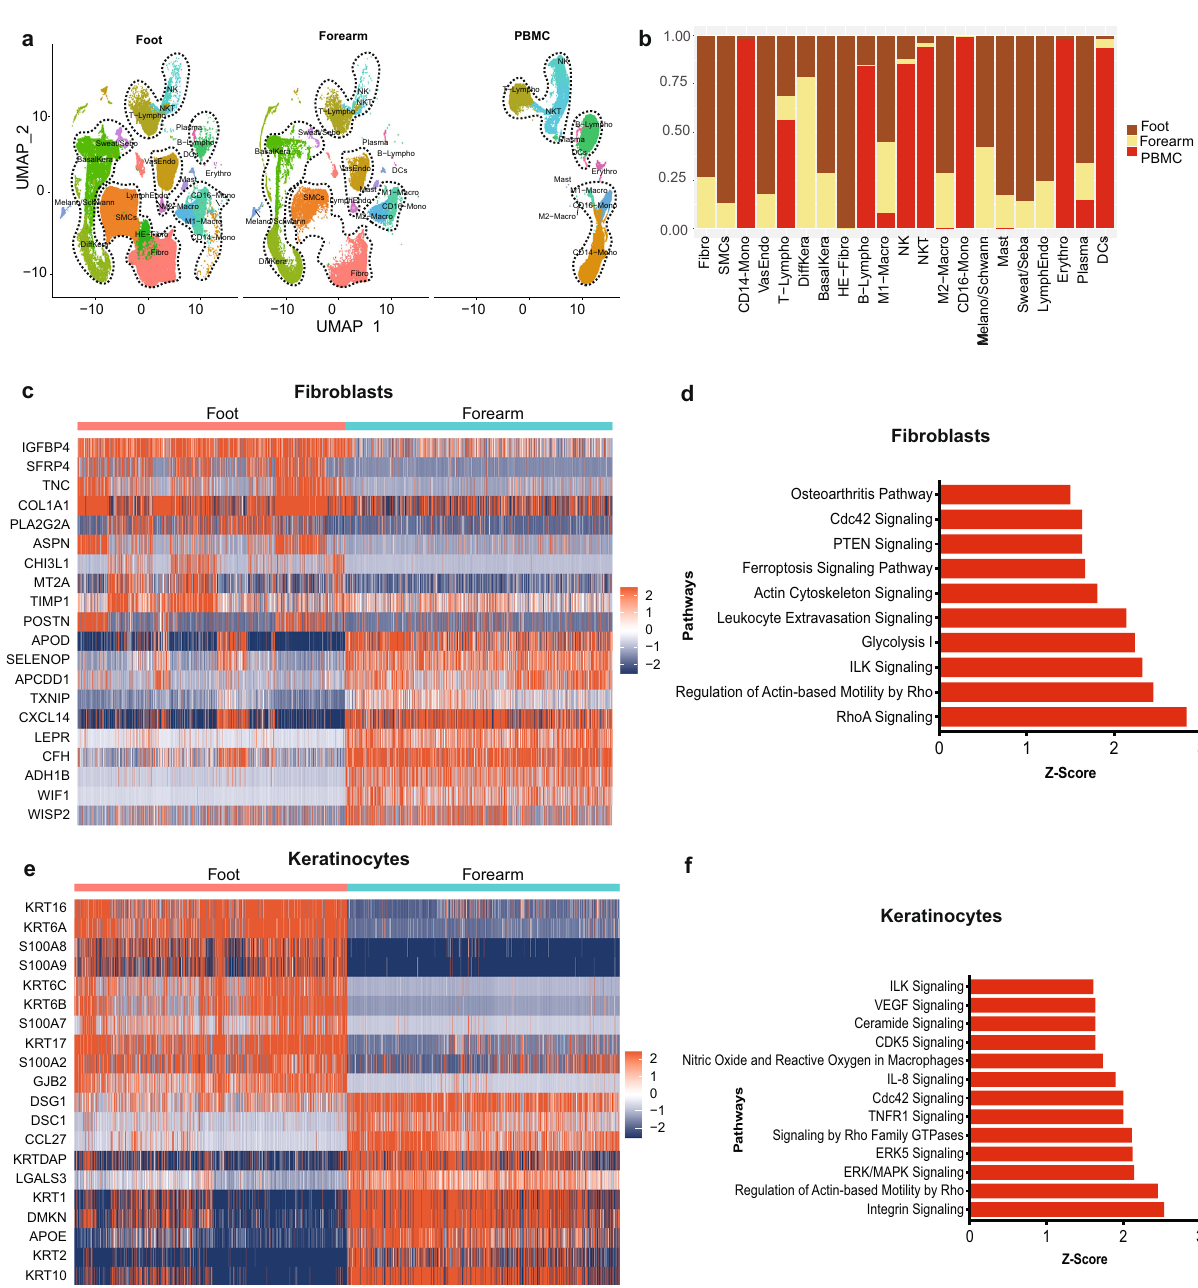
Fig. 2 Comparative single-cell transcriptome analysis pro fi les of foot, forearm, and PBMCs, delineating gene signatures, and biological pathways across anatomical sites. a Split UMAP of Foot, Forearm, and PBMC samples. The cell clusters were annotated manually according to various canonical and novel cell types based on expression of speci fi c markers (as described in Fig. 1b, c). Dotted lines are drawn around cell groups of similar lineages. b Stacked bar plots showing the proportion (y-axis) of different cell type from foot, forearm, and PBMC. Dark brown: foot, beige: forearm, red: PBMCs. c Heatmap showing signi fi cantly differentially expressed genes between foot and forearm fi broblast cell clusters. Relative gene expression is shown in pseudo color, where blue represents downregulation, and red represents upregulation. d Pathway enrichment analysis on genes that are signi fi cantly differentially expressed between foot and forearm cell fi broblast clusters. The pathways analysis was performed using Ingenuity Pathways analysis (IPA) tool that calculate signi fi cance of impact on pathways using one-tailed Fisher ’ s exact test and Z-score. The pathways with P value < 0.01 and Z score >2 were considered signi fi cantly activated. e Heatmap showing signi fi cantly differentially expressed genes in keratinocytes cell clusters between foot and forearm samples. f Pathway enrichment analysis on genes that are signi fi cantly differentially expressed between foot and forearm keratinocytes cell